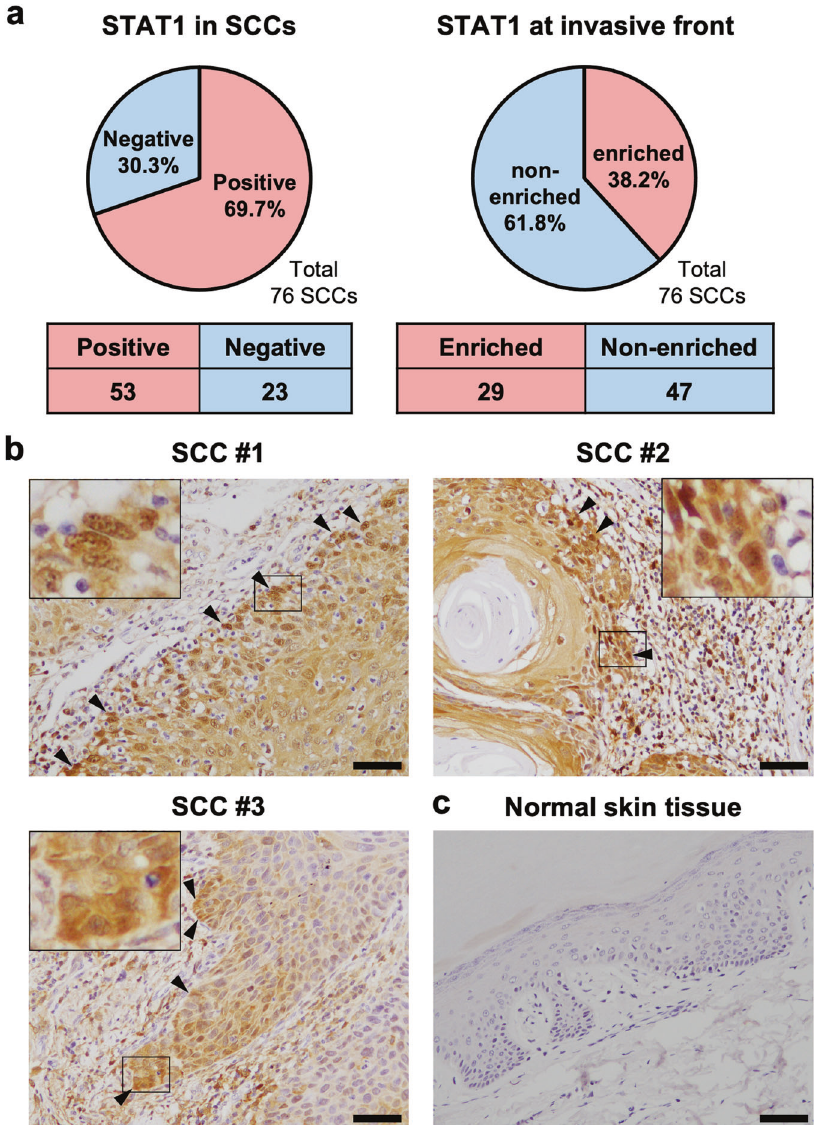
Fig. 6 STAT1 is highly expressed at the invasive front of skin SCCs. a The pie charts and tables show the percentage and number of STAT1 positive skin squamous cell carcinoma (SCC) in human tissue microarray (left) and those of SCC with enriched STAT1 at the invasive front (right), respectively. The results were independently assessed by two pathologists. b Representative images showing enrichment of STAT1 in the invasive front of SCC. Arrowheads indicate high STAT1 expression in leading cancer cells at the invasive fronts of SCC cancer cell groups. The regions surrounded by squares were magni fi ed. The scale bars represent 50 µm. c Representative images showing STAT1-negative in normal skin tissues. Scale bars represent 50